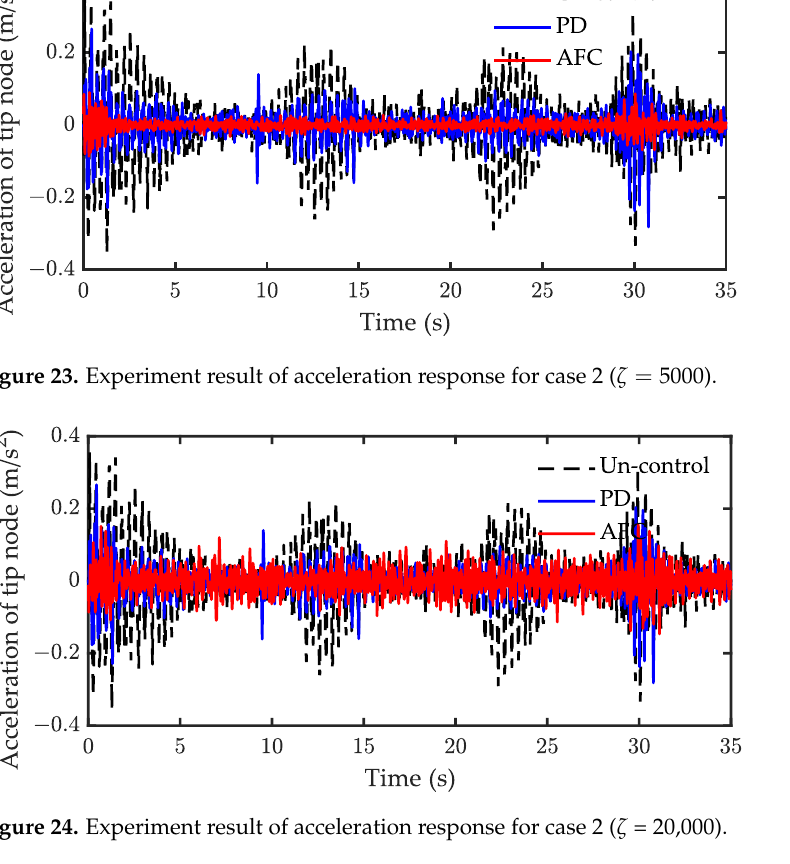
Table 5. Vibration suppression effect of the experimental system for case 2 ( ζ =